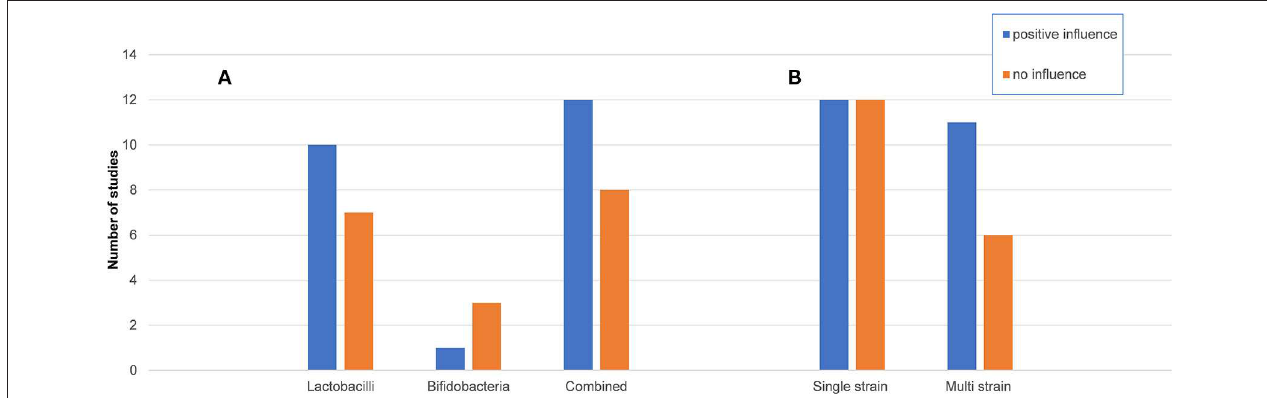
FIGURE 3 | Effect of probiotic supplementation on URTI, GI problems and the immune system by probiotic strain. Columns illustrate the number of studies reporting positive effects on upper respiratory tract infections (URTI), gastrointestinal (GI) problems or the immune system for the different probiotic (A) genera and their combination and (B) single or multi strain preparations. Lactobacilli , preparations only including Lactobacillus strains; Bifidobacteria , preparations only including Bifidobacterium strains; combined, including different Lactobacillus and Bifidobacteria strains with or without different other genera; single strain, only one strain of Lactobacillus or Bifidobacteria was given; multi strains, any combination of different Lactobacillus and/ or Bifidobacteria was given. Positive influence was defined as any significant positive effect on URTI, GI and the immune system based on author’s